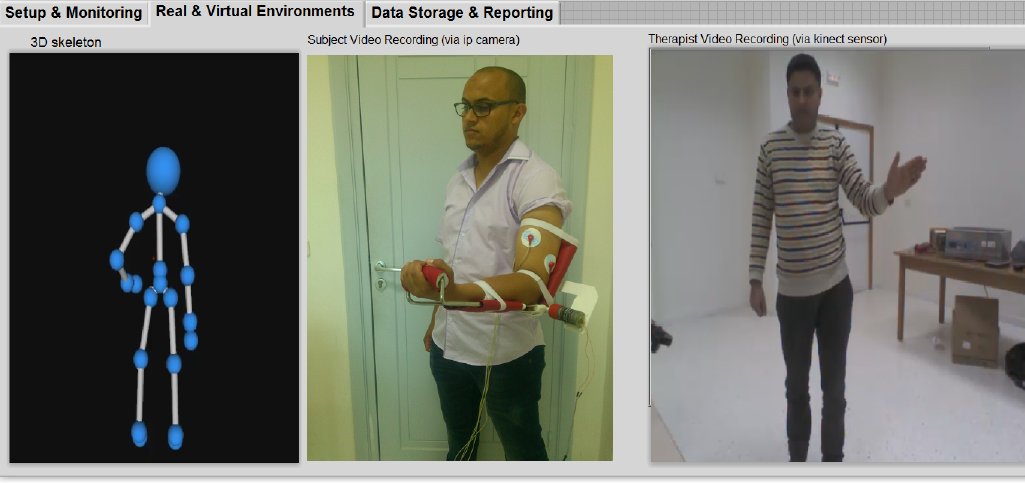
Figure 6. Real time